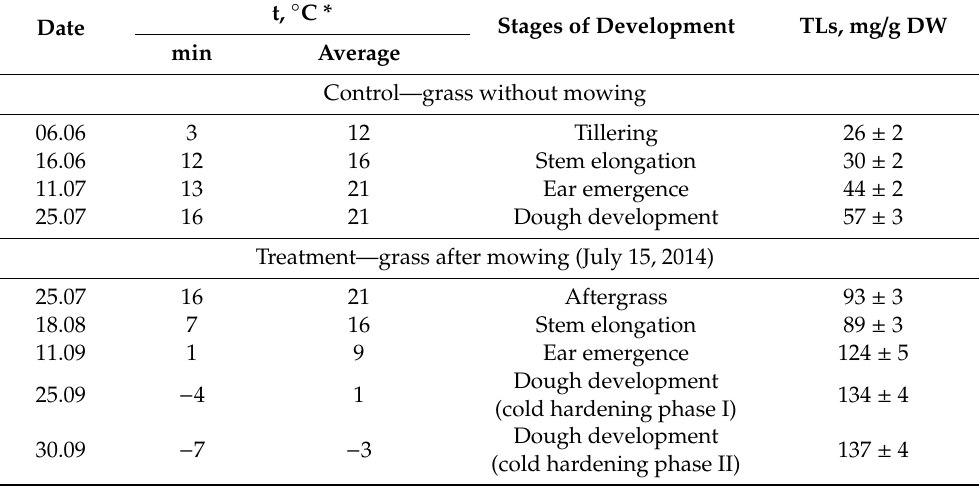
Table 2. Total contents of lipids (TLs, mg / g dry weight ± standard error) in the leaves of the perennial cereal Bromopsis inermis growing at di ff erent temperatures, at di ff erent stages of development.